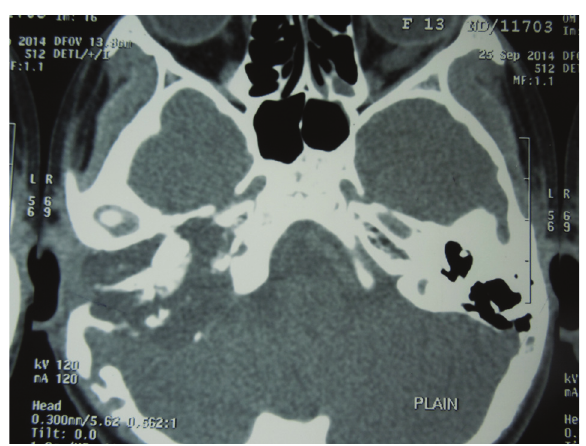
Histopathological picture of myxoma (×10 magnification).